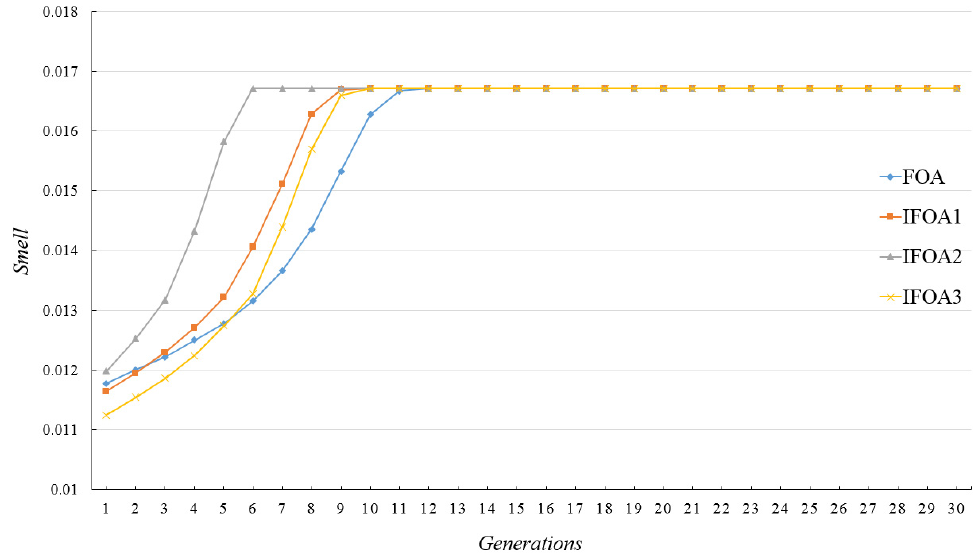
Figure 11. Optimization result using FOA and IFOAs to remove Gaussian noise from noisy image (Lena).